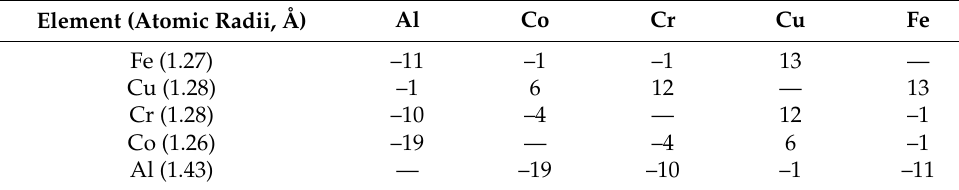
Table 5. Enthalpies of mixing between elements